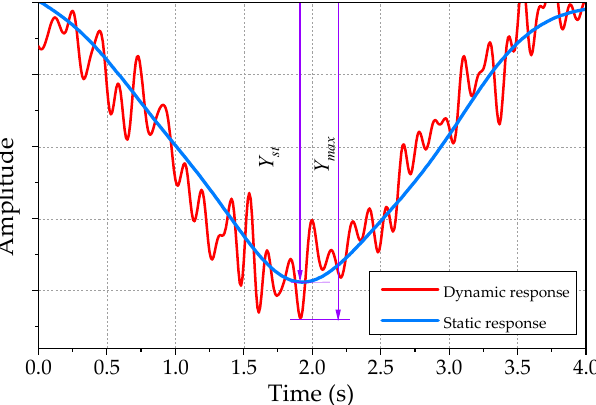
Figure 2. Principle of conventional DLA.